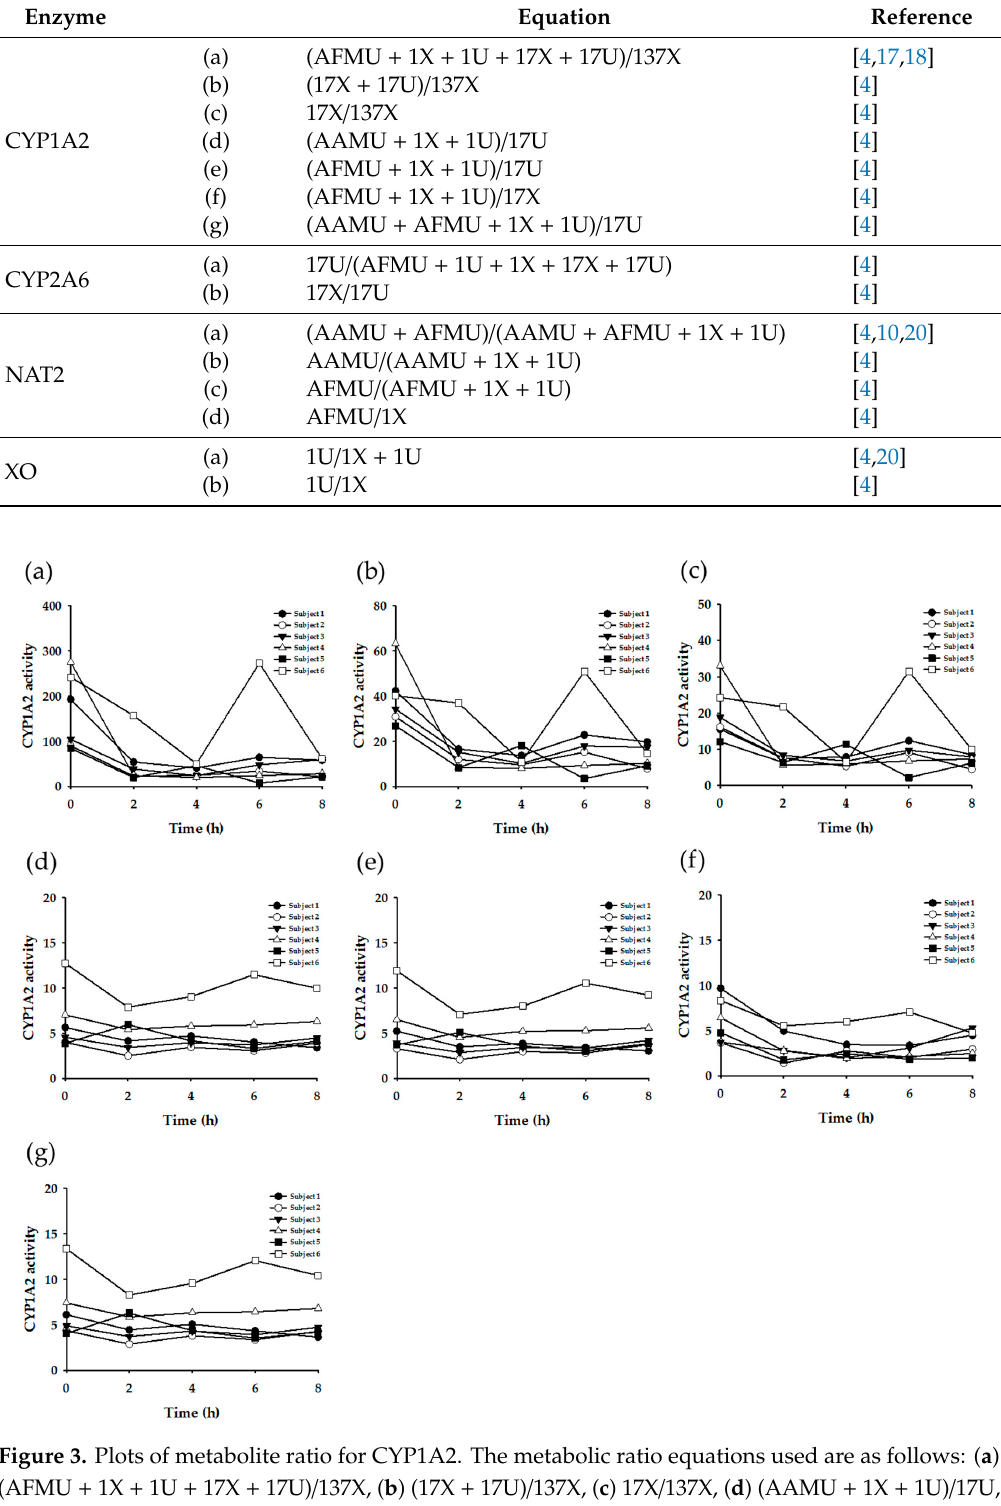
Table 3. Equations of ca ff eine metabolic ratios used for enzyme-specific activities.